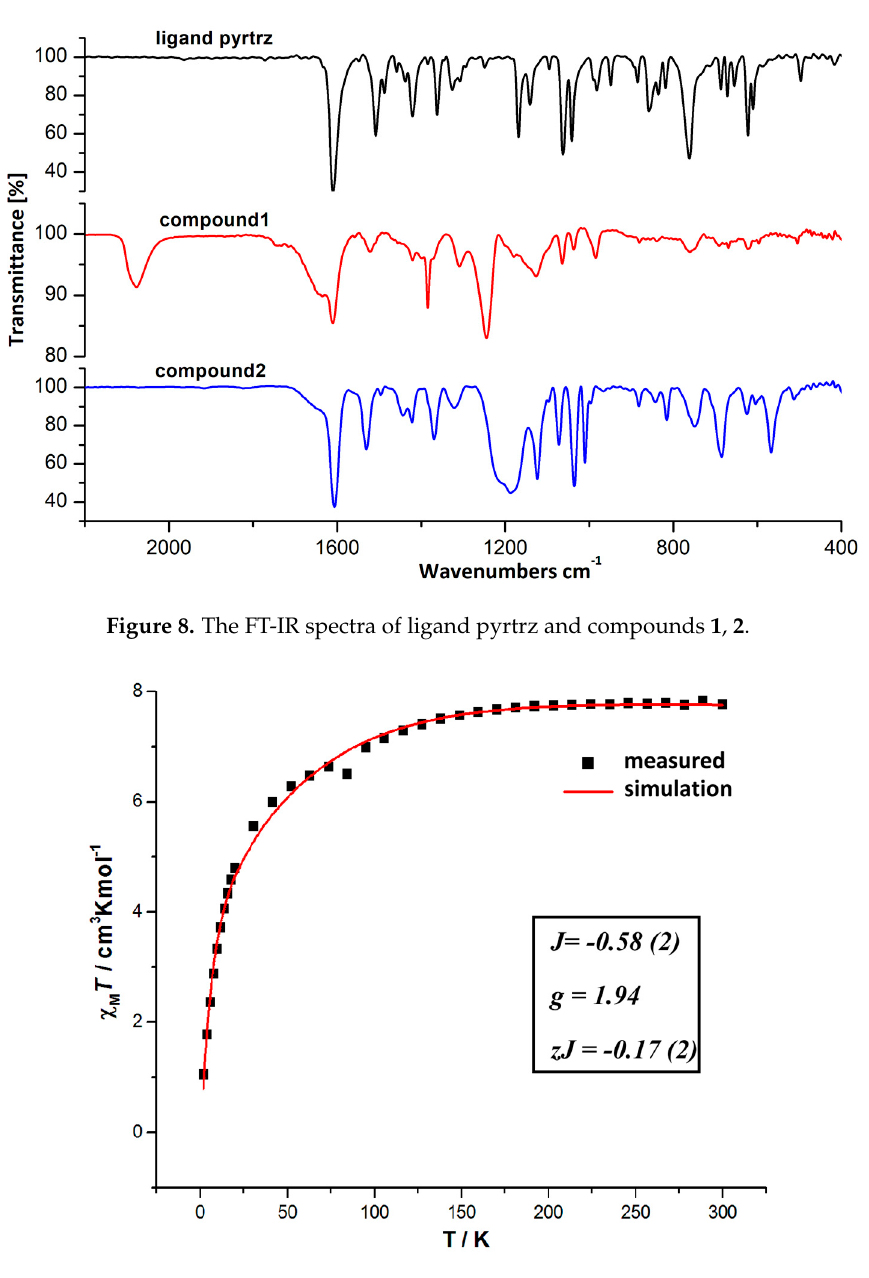
Figure 9. The temperature-dependent magnetic susceptibility for compound 1 (the solid line represents the best fit